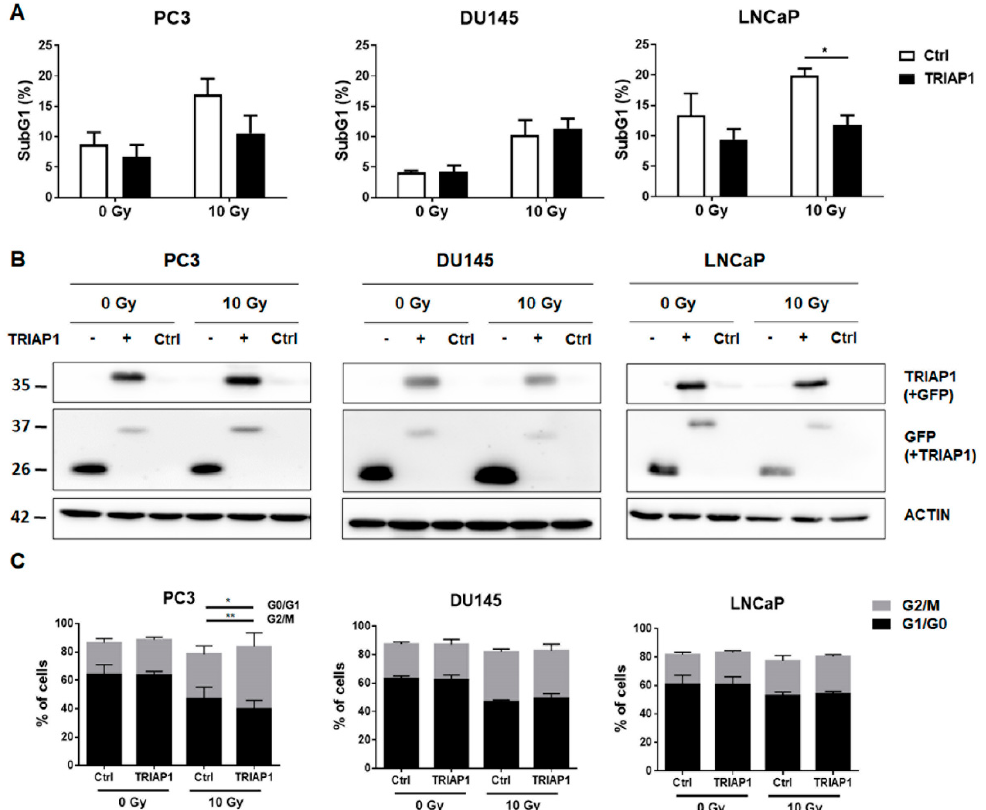
Figure 2. Ectopic TRIAP1 expression in prostate carcinoma cells results in radiation resistance.